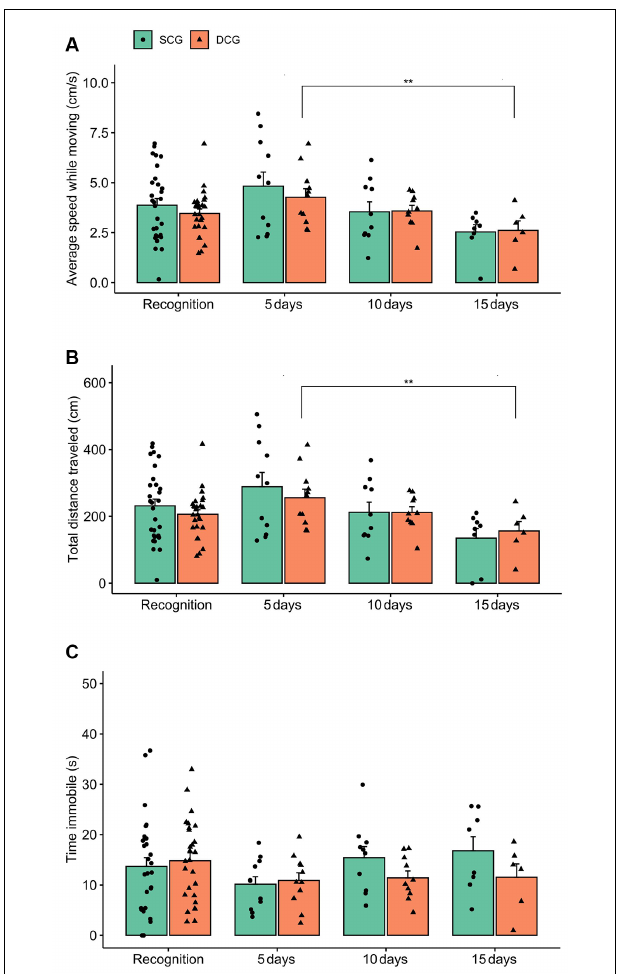
FIGURE 4 | Locomotor behavior comparison between the SCG and DCG. Bars indicate dusky damselfish Stegastes fuscus locomotor behavior (Mean + SE) for 10 min in the test tank: (A) average speed while moving; (B) total distance traveled, and (C) time immobile. Two-way ANOVA was performed and the asterisk indicates a significant value in SCG and DCG comparison during the recognition experimental phase (two-way ANOVA; p = 0.003). Time immobile was not statistically significant between groups.